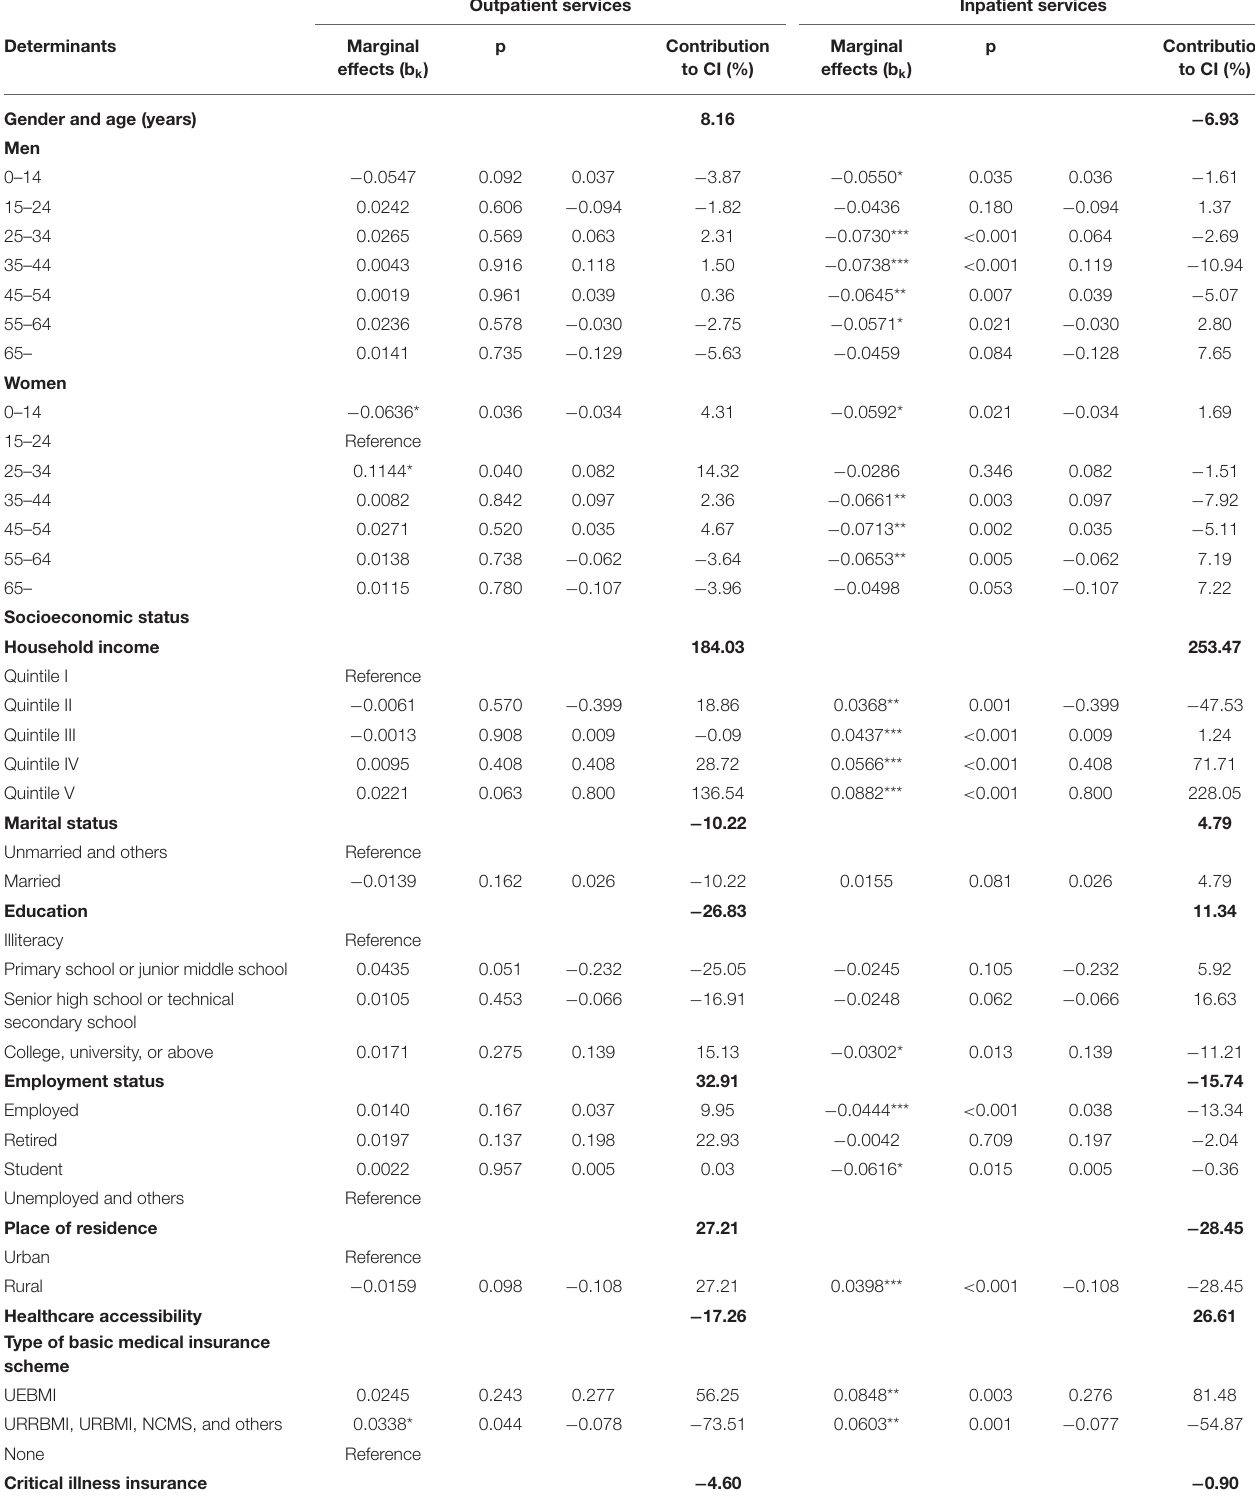
TABLE 4 | Decomposition of household income-related inequalities in outpatient and inpatient services